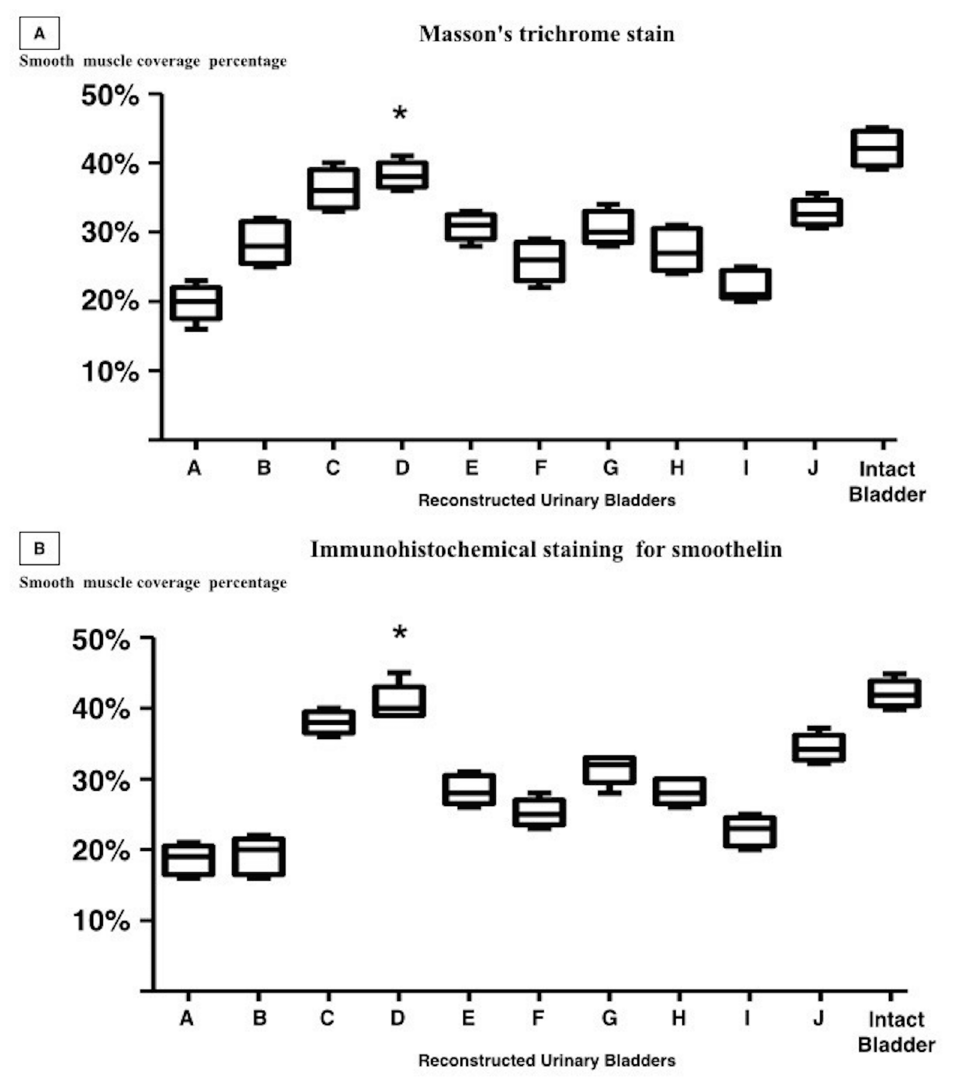
Fig 7. Percentage of the reconstructed bladder wall covered with smooth muscle. Staining with (A) TRI and (B) anti-smoothelin staining. The regenerated bladder wall with a statistically similar (TRI [p = 0.03] and anti-smoothelin staining [p = 0.35]) smooth muscle content compared to the bladder wall in the control group ( *